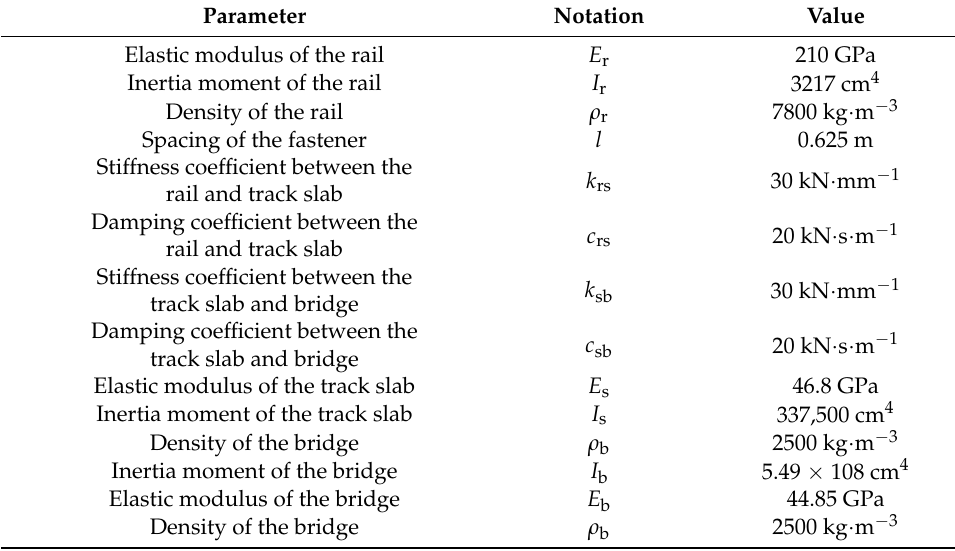
Table 2. The Parameters of Track-Bridge